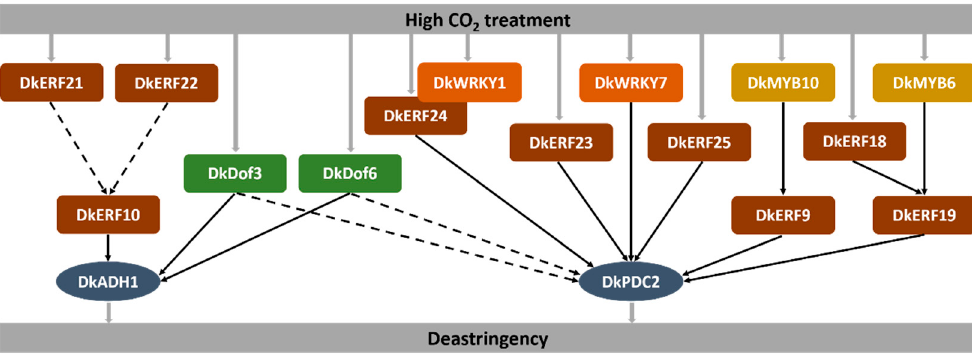
Figure 7. The proposed regulatory roles of TFs to the promoters of DkADH1 and DkPDC2 . DkDof3 and DkDof6 were newly discovered in this study. Black solid arrows indicate direct regulation and black dashed arrows mean indirect regulation. DkDof3 and DkDof6 were repressors.